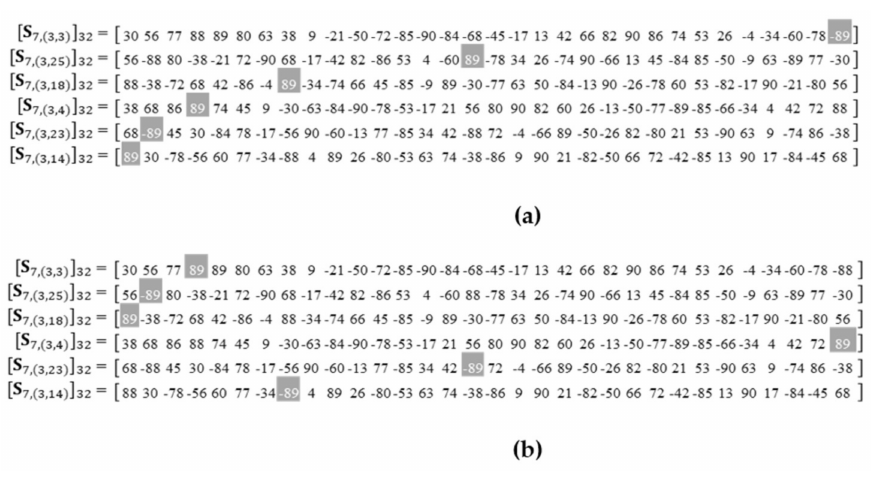
Figure 16. Removing the case not obtaining full kernel matrix by tuning values highlighted. ( a ) Method 1; ( b ) Method 2.